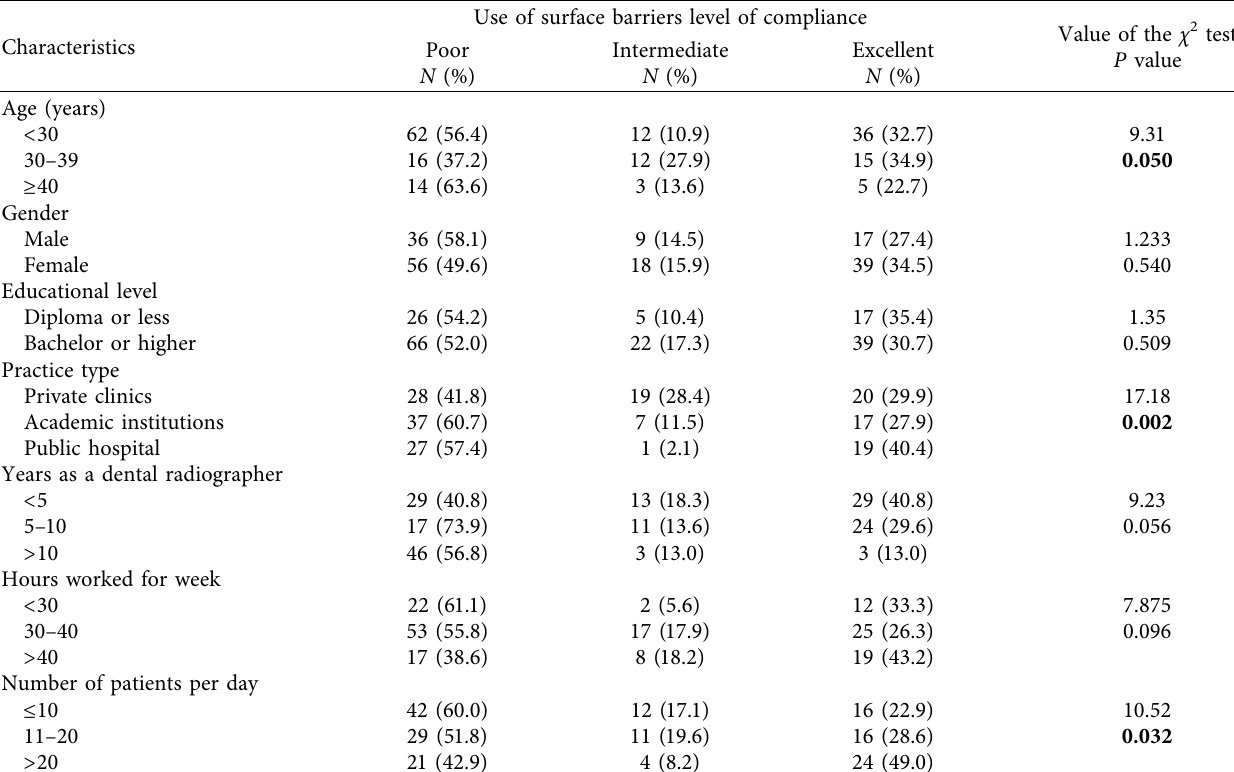
Table 7: The level of compliance with the use of surface barriers ( N �